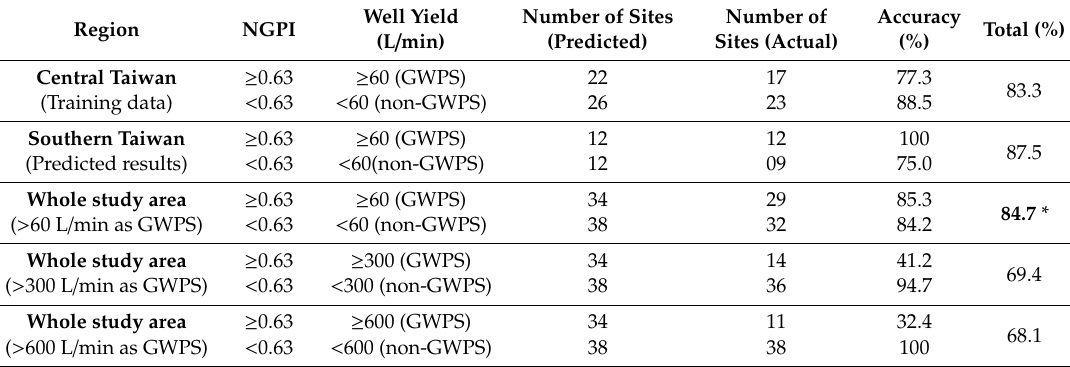
Table 5. Statistical results of NGPI, well yield, GWPS, and